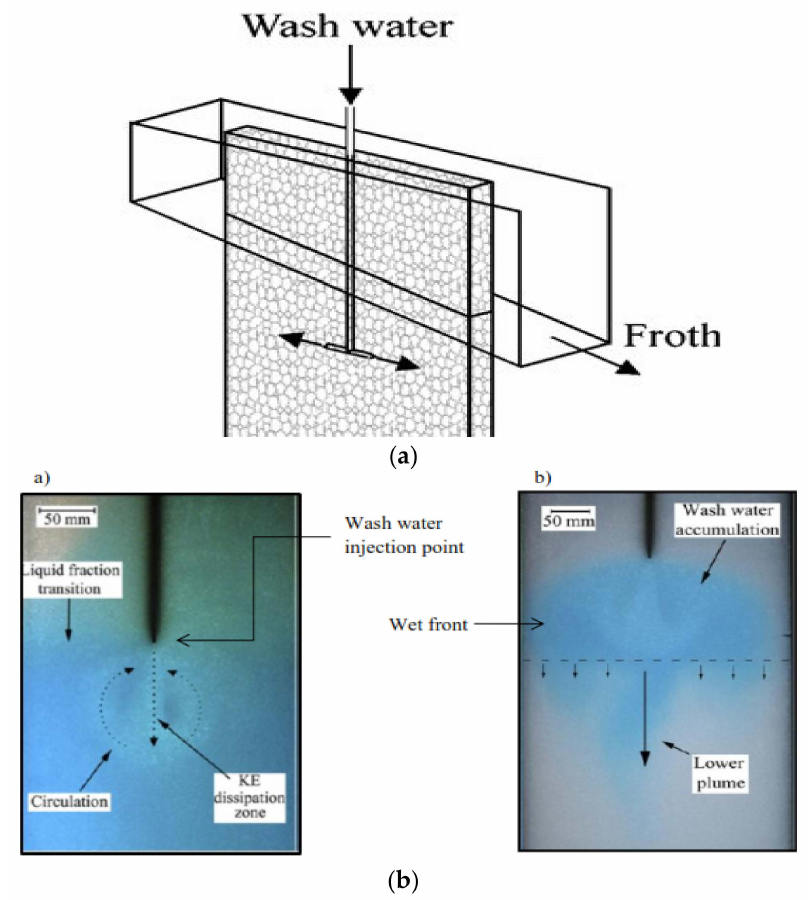
Figure 9. Plunging/submerged nozzles, ( a ) Submerged horizontal (T-shaped) injector used to inject a horizontal jet of wash water into the froth column; ( b ) Photograph of a plunging jet/vertical injector